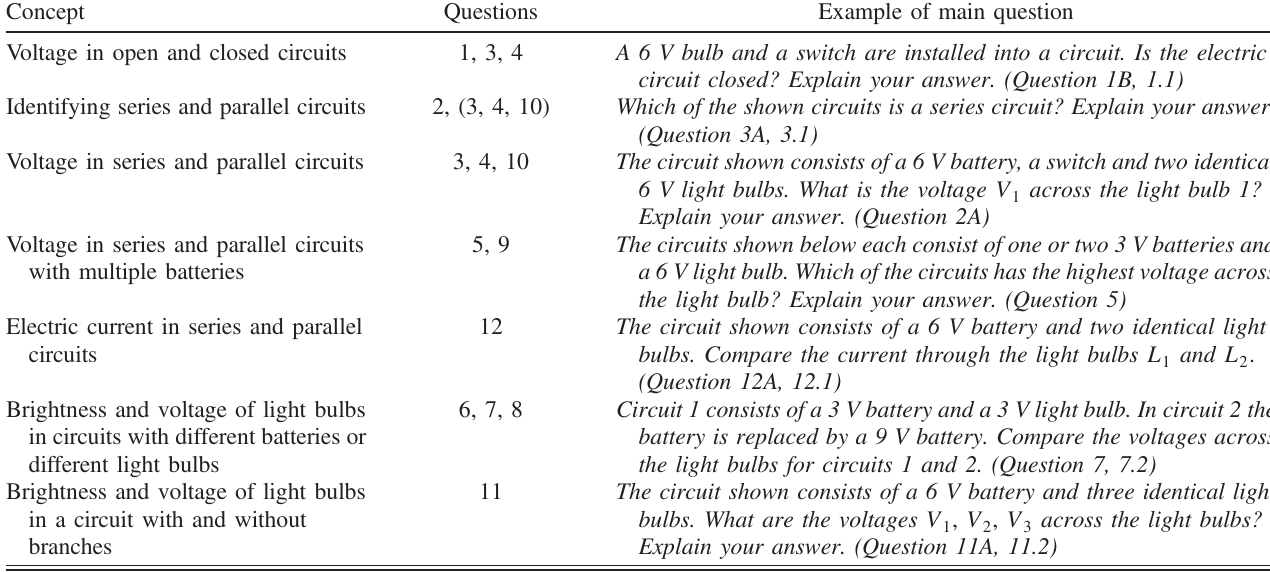
TABLE I. Main topics of the interview